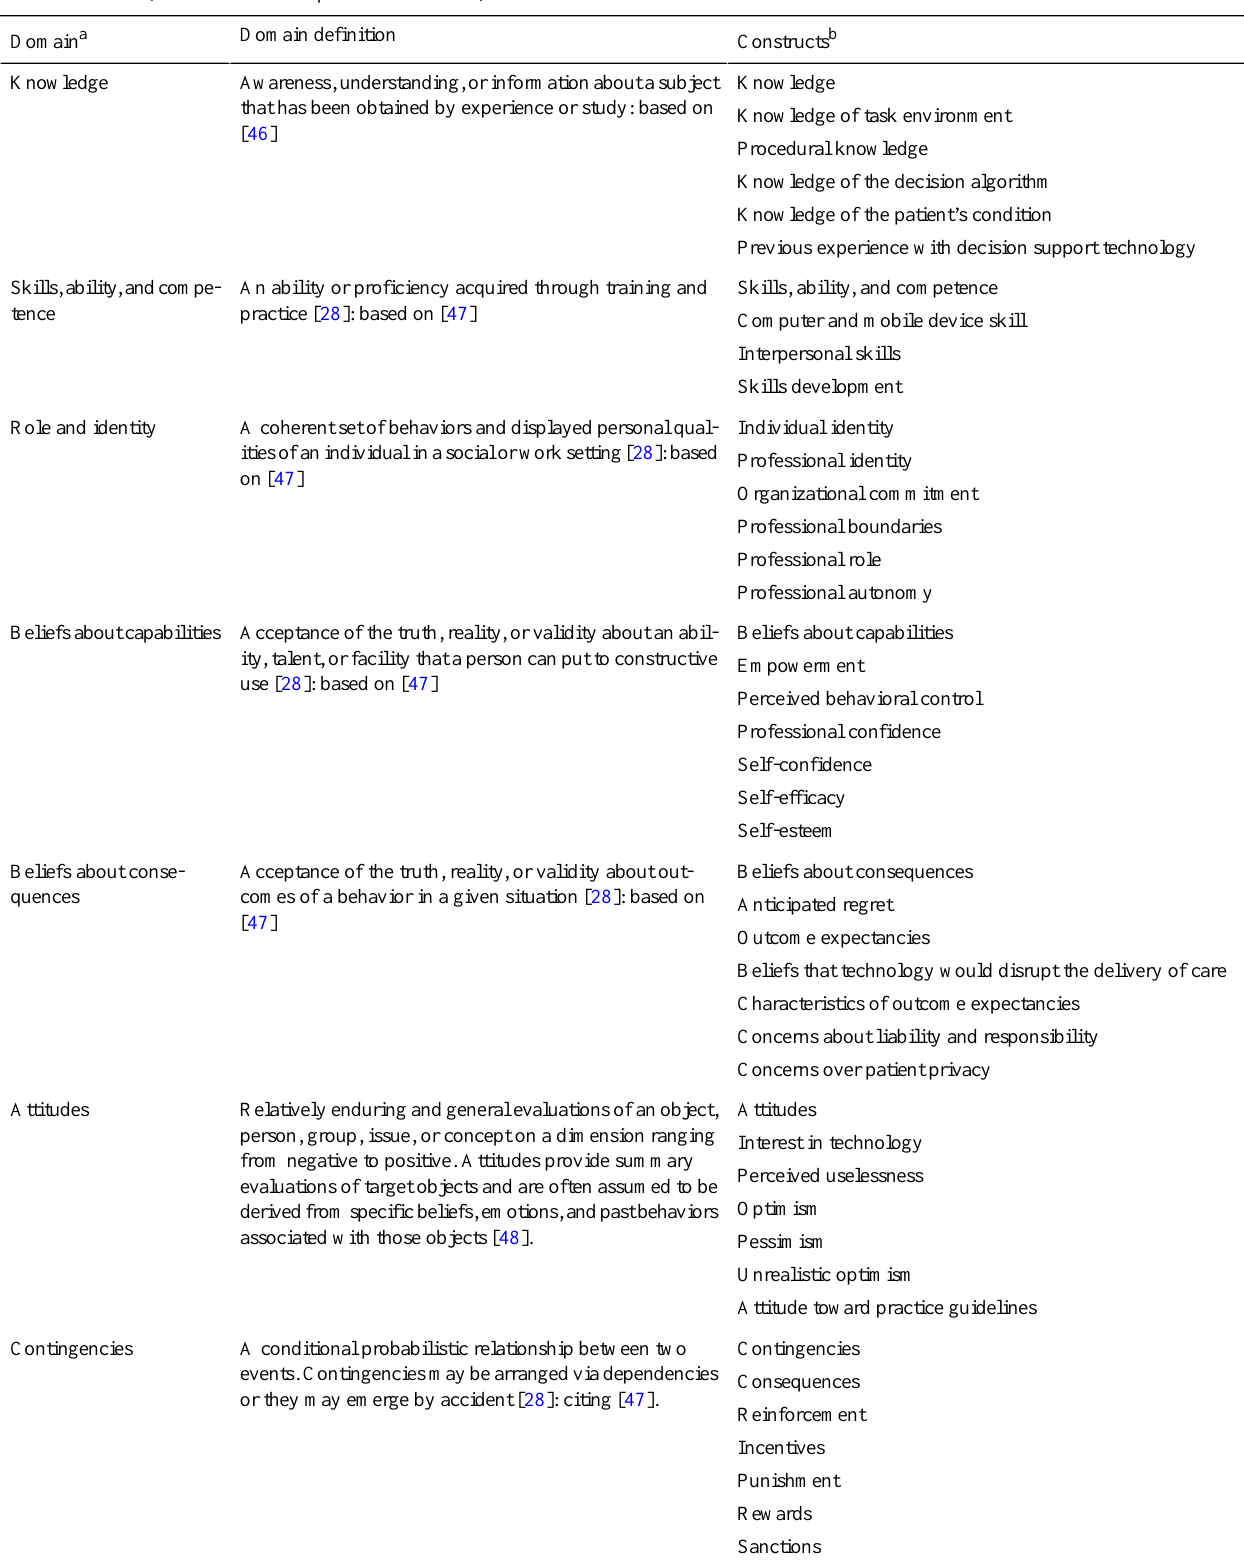
Table 2. BEAR (BEhavior and Acceptance fRamework) constructs and